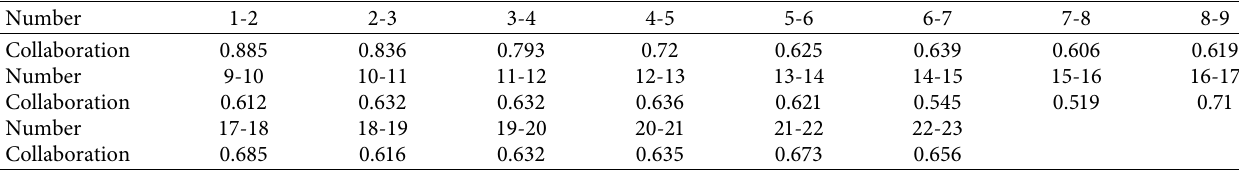
Table 3: Collaboration degree of railway transportation nodes.